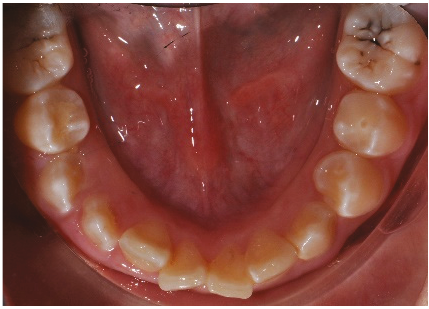
Figure 3: Periapical radiograph of tooth 45 after apexi fi cation with EndoSequence Root Repair